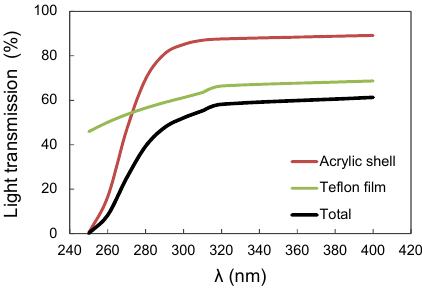
Figure 2. Light transmission spectra of the PFA Teflon film (yellow line), the acrylite shell (red line) and their total transmission in the UV range (black